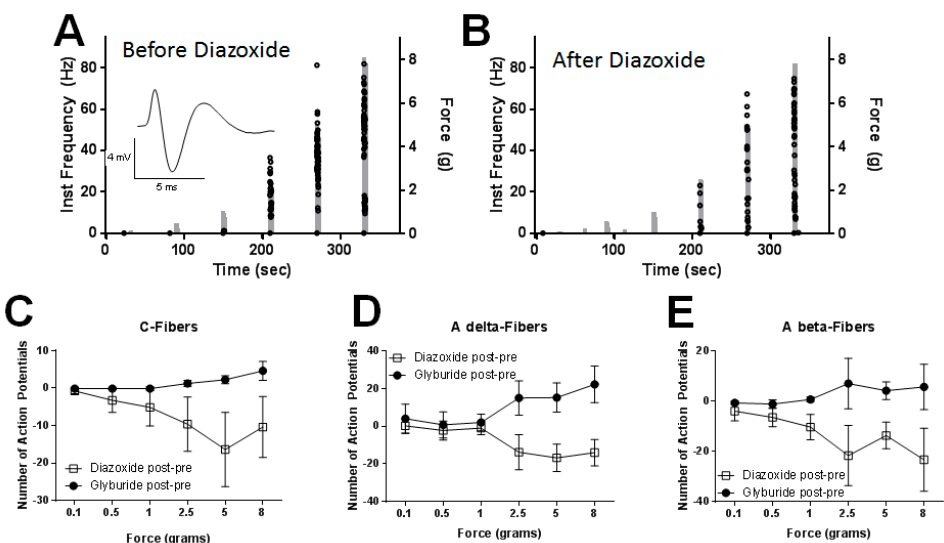
Figure 10. The SUR1 agonist, diazoxide, decreases mechanical responsiveness of unmyelinated, C-fibers. ( A ) Increase in number (dots) and peak instantaneous frequency (left y -axis) of C-fiber action potentials as the force of stimulation is increased in a step-wise fashion (right y -axis). Inset: Example trace from recording. ( B ) Application of diazoxide (100 uM, 10 min) to the receptive field of a C-fiber decreases the number of action potentials compared to before application. ( C ) Diazoxide decreases C-fiber responses to increasing mechanical stimulation in SNL mice (F (5,70) = 3.70, p = 0.025); Tukey post-hoc comparing 0.1 g versus 5 g and 8 g; 95% CI = 3.05 to 28.2 and 0.55 to 25.7, respectively; n = 8 /